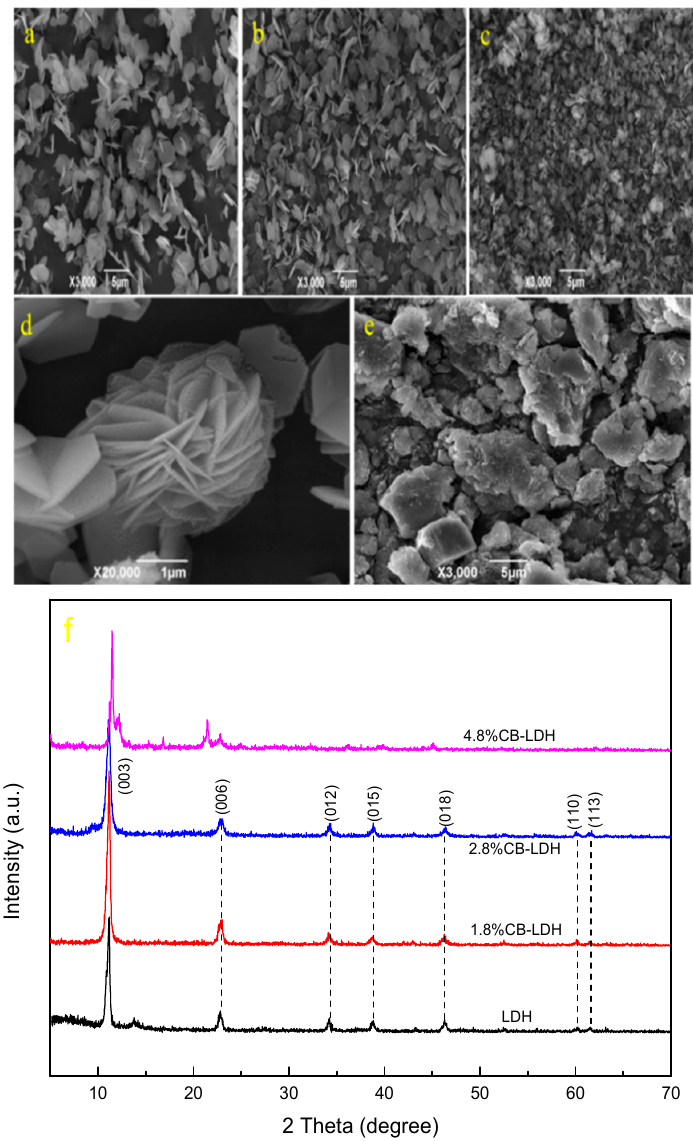
Figure 1. SEM images ( a – e ) ( a = 0%; b = 1.8%; c , d = 2.8%; and e = 3.8%) and XRD patterns ( f ) of MgAl- LDH (layered double hydroxide) derived from of surfactant solutions of different concentrations. The phase purity of the obtained hydrotalcite was determined by XRD analysis. As shown in Figure 1f, when the concentrations of the surfactant were 1.8% and 2.8%, the XRD patterns of the prepared MgAl-LDH (1.8%CB-LDH and 2.8%CB-LDH, respectively) showed characteristic diffractions of LDH materials corresponding to the (003), (006), (009), (015), (018), (110), and (113) crystal planes [19,20], which was consistent with the layered structure of hydrotalcite in the SEM images. Moreover, the intensity of the diffraction peak in the hydrotalcite (2.8%CB-LDH) was lower than that of traditional hydrotalcite (0.9MLDH), indicating the reduction in the spacing of the hydrotalcite layers. However, when the concentration of the surfactant increased to 4.8%, the layered structure disappeared